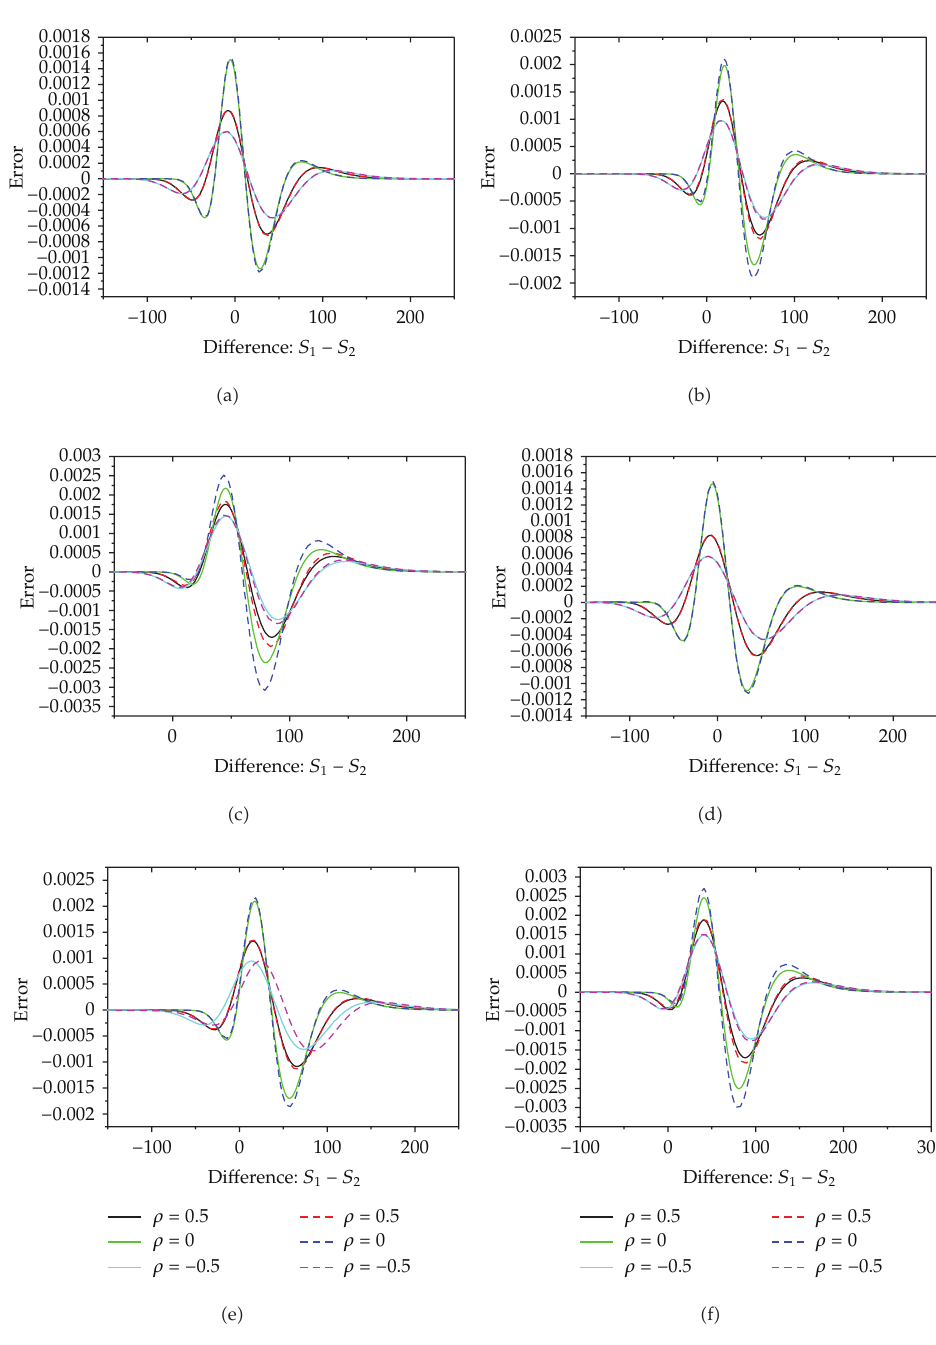
Figure 4: Error versus S 1 − S 2 : the error is calculated by subtracting the approximate estimate from the exact result. The dash lines denote the errors of the approximate shifted square-root process, and the solid lines show the errors of the approximate shifted lognormal process. (cid:3) a (cid:4) S 10 (cid:7) 110, S 20 (cid:7) 100, σ 1 (cid:7) 0 . 25, and